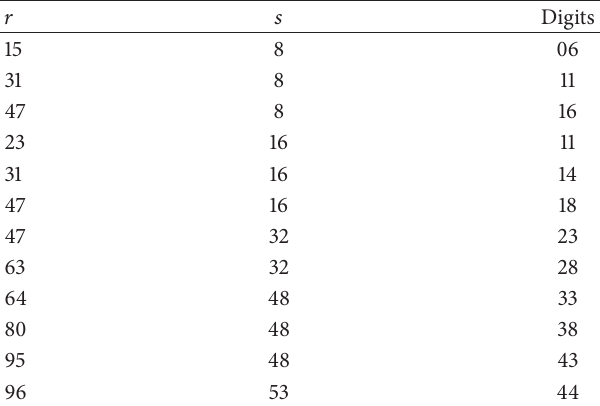
Table 1: Different orders of 𝑀 with 𝑝 = 2